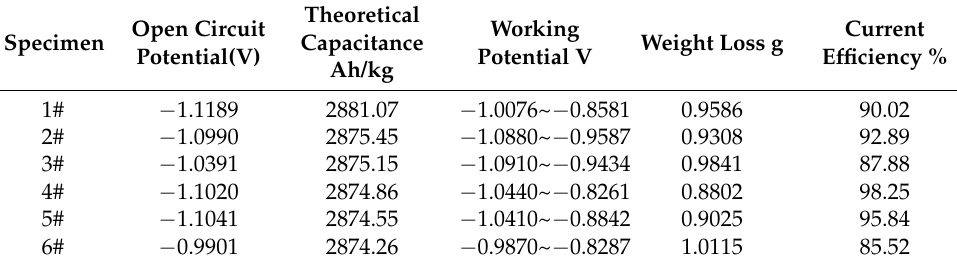
Table 3. Open circuit potential and current efficiency of anode sample by adding Ga.